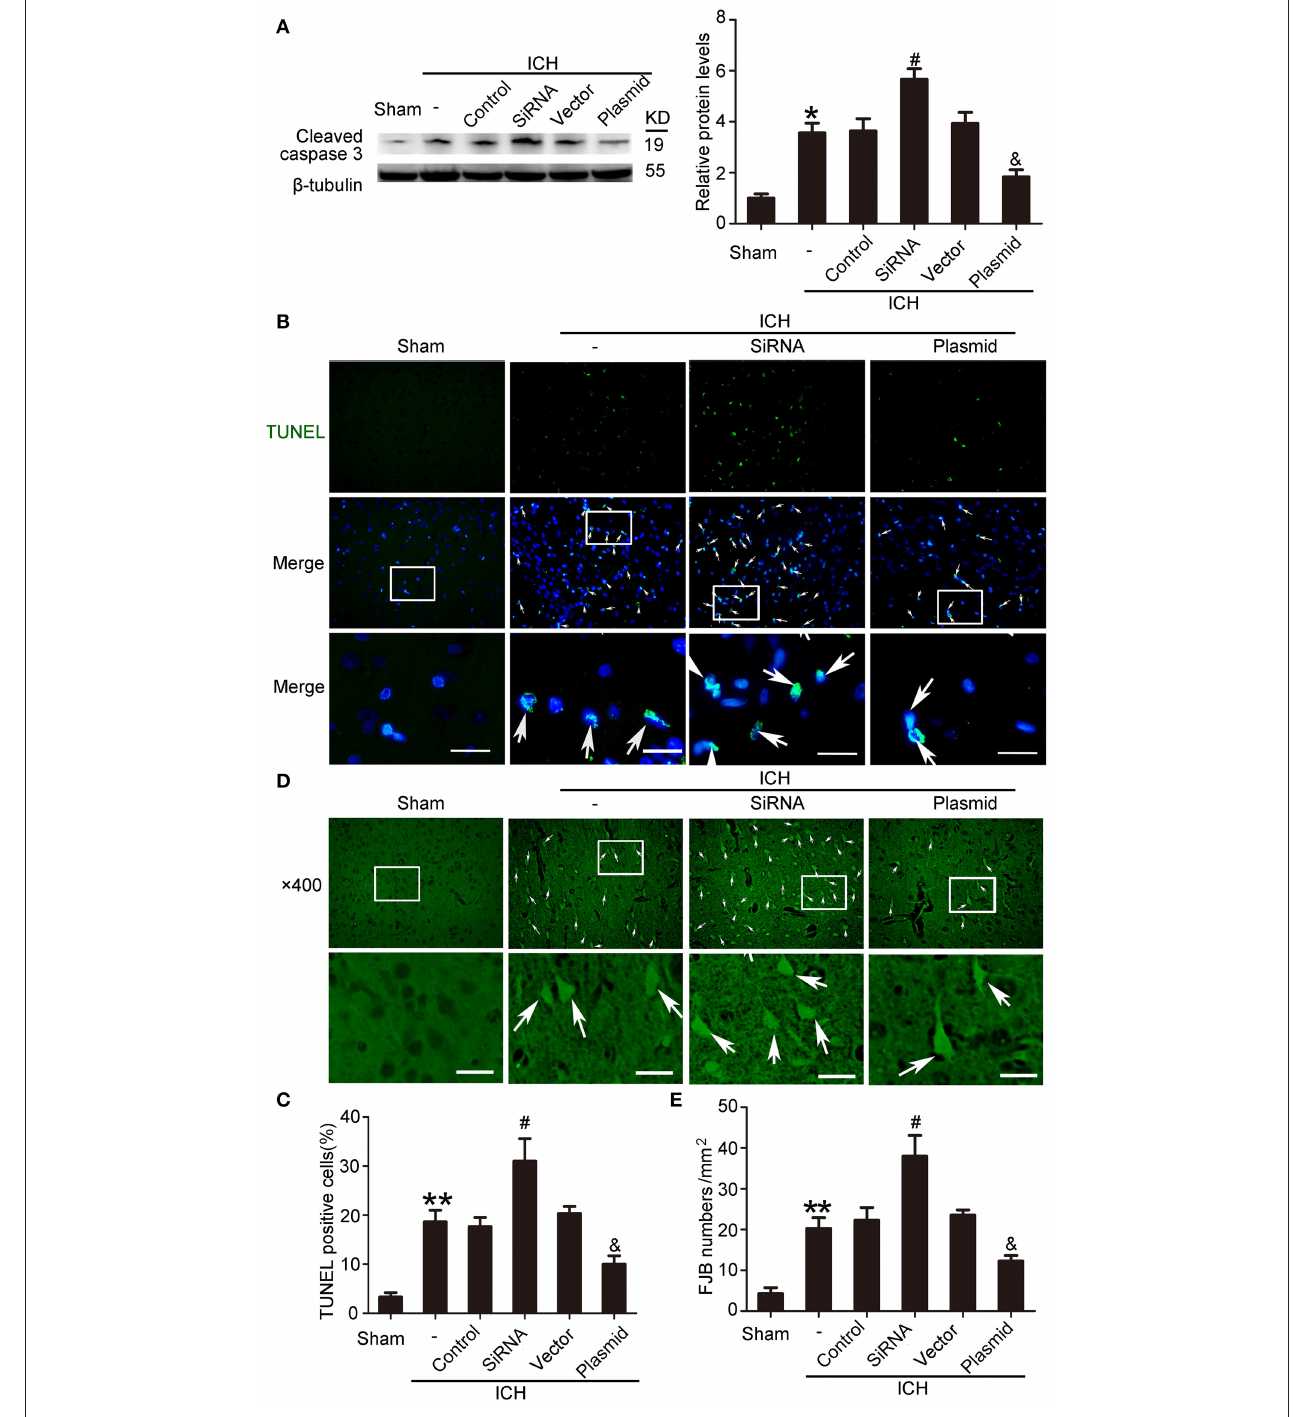
FIGURE 10 | Effects of KIF1A intervention on ICH-induced SBI. (A) Western blot of protein levels of cleaved caspase-3. All values are expressed as mean ± SEM. Mean values of protein levels in the sham group were normalized to 1.0. * p < 0.05 vs. the sham group, # p < 0.05 vs. the ICH + control siRNA group, & p < 0.05 vs. the ICH + vector group, n = 6. (B) TUNEL (green) with DAPI (blue) staining in the peri-hematoma cortex. Arrows indicate TUNEL-positive cells. Scale bar = 32 µ m. (C) Determination of the percentage of TUNEL-positive cells. All values are expressed as mean ± SEM. ** p < 0.01 vs. the sham group, # p < 0.05 vs. the ICH + control siRNA group, & p < 0.05 vs. the ICH + vector group, n = 6. (D) FJB staining (green) shows neuronal degradation in the peri-hematoma cortex. Scale bar = 32 µ m. Arrows indicate FJB-positive cells. (E) Number of FJB-positive cells/mm 2 was determined. All values are expressed as mean ± SEM. ** p < 0.01 vs. the sham group, # p < 0.05 vs. the ICH + control siRNA group, & p < 0.05 vs. the ICH + vector group, n = 6.